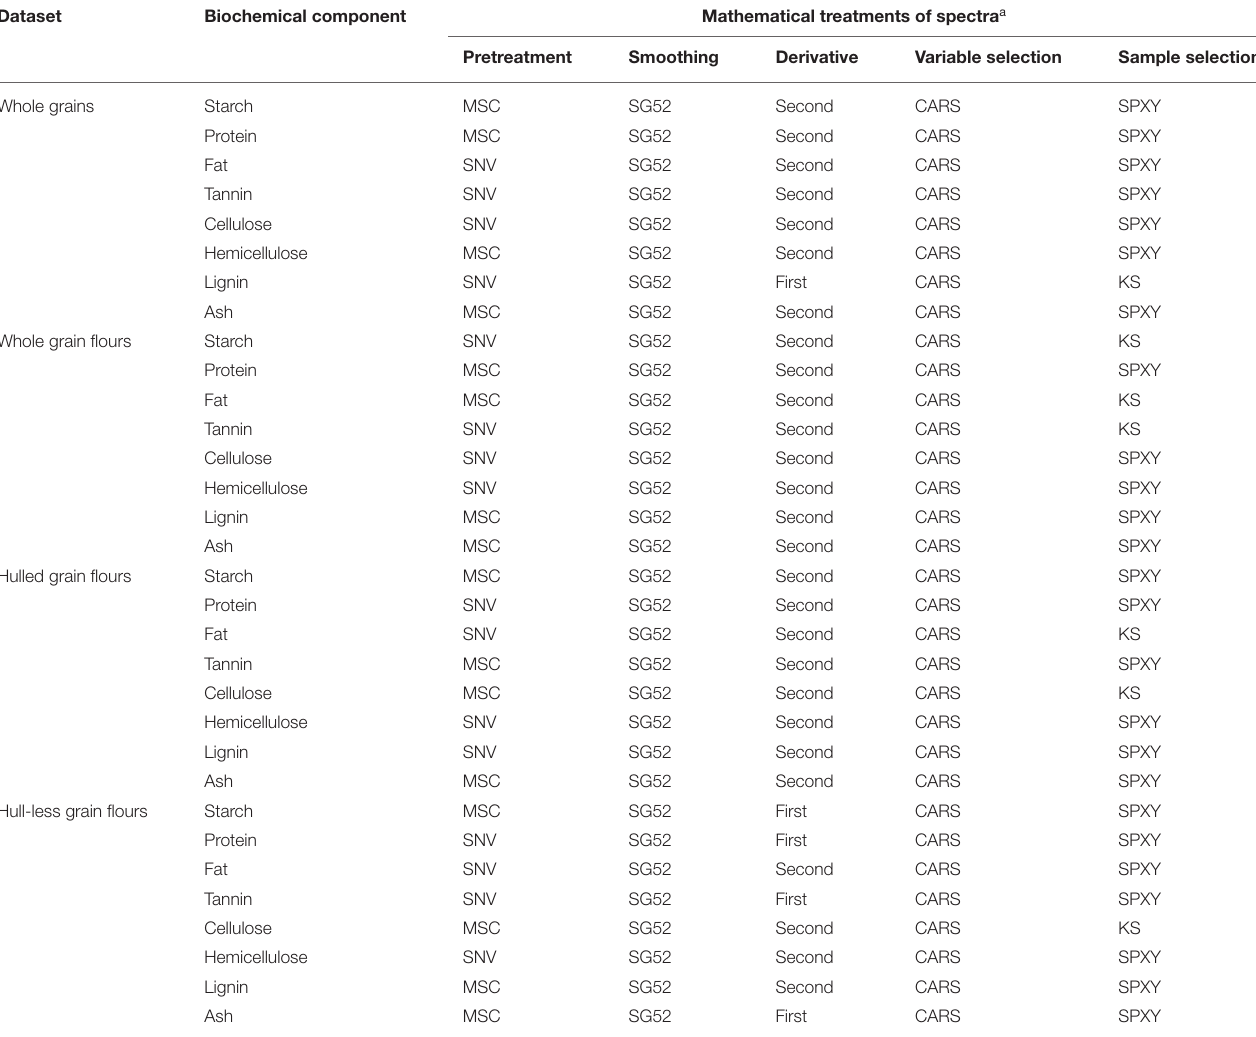
TABLE 2 | The PLSR followed by mathematical treatments of spectra to remove random noise and to construct FT-NIR models for biochemical components (starch, protein, fat, tannin, cellulose, hemicellulose, lignin, and ash) of whole grains, whole grain flours, hulled, and hull-less grain flours of sorghum.